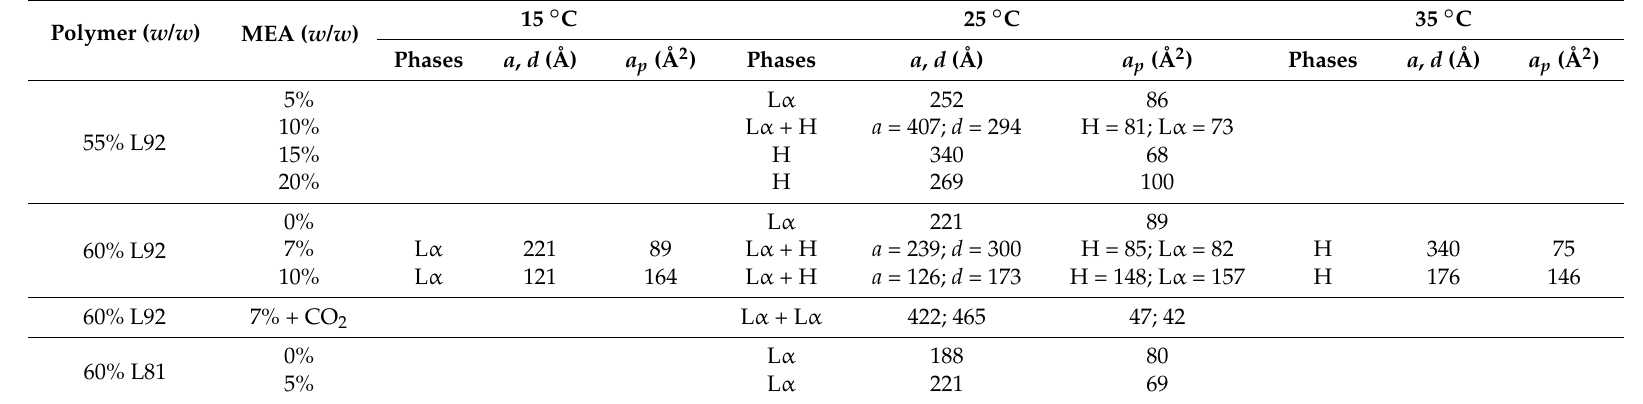
Table 2. Phases, lattice parameters, and interfacial areas of the birefringent samples along the dilution